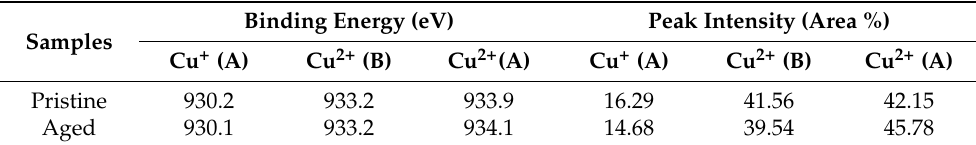
Table 5. Detailed characteristics of the XPS Cu2p 3/2 spectra in Figure